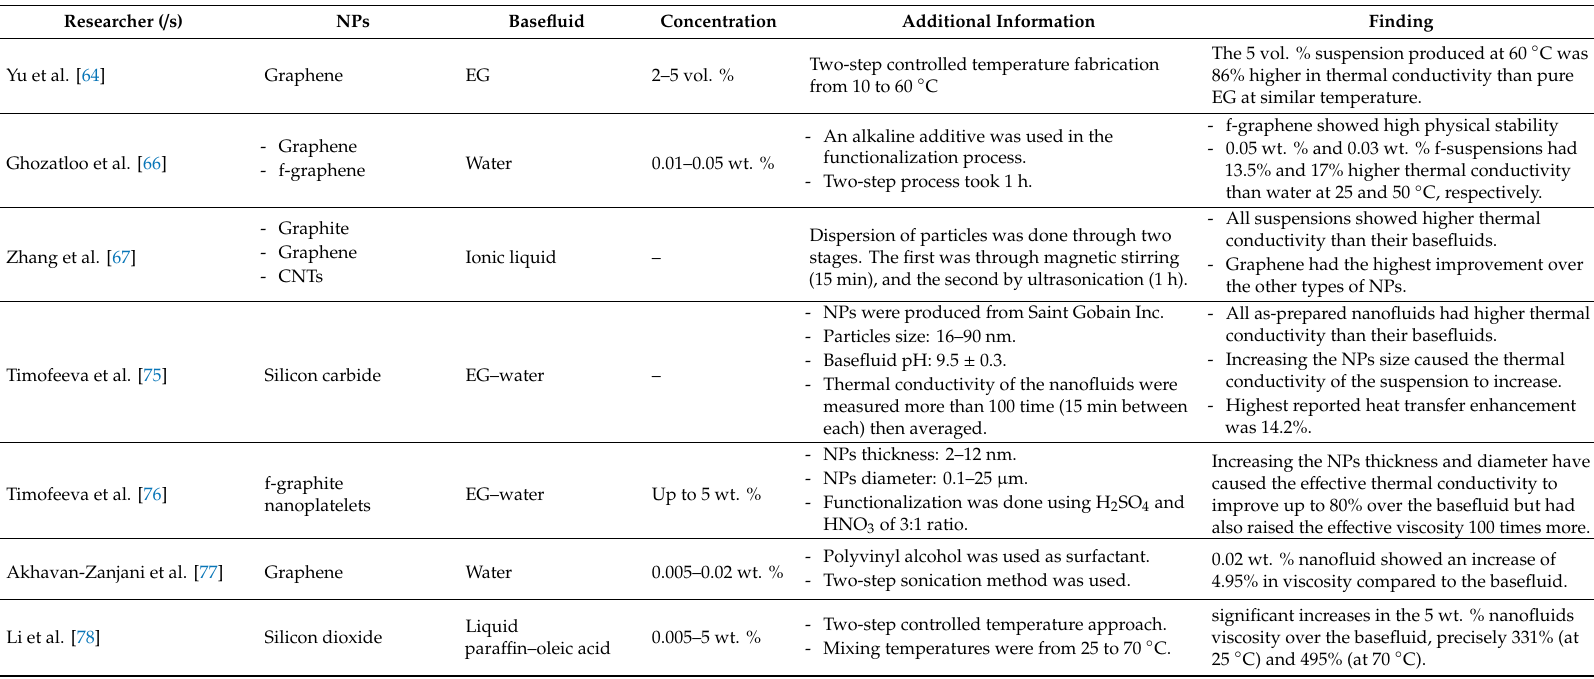
Table 3. A summary of some of the available studies that focused on nanofluids e ff ective thermal conductivity and